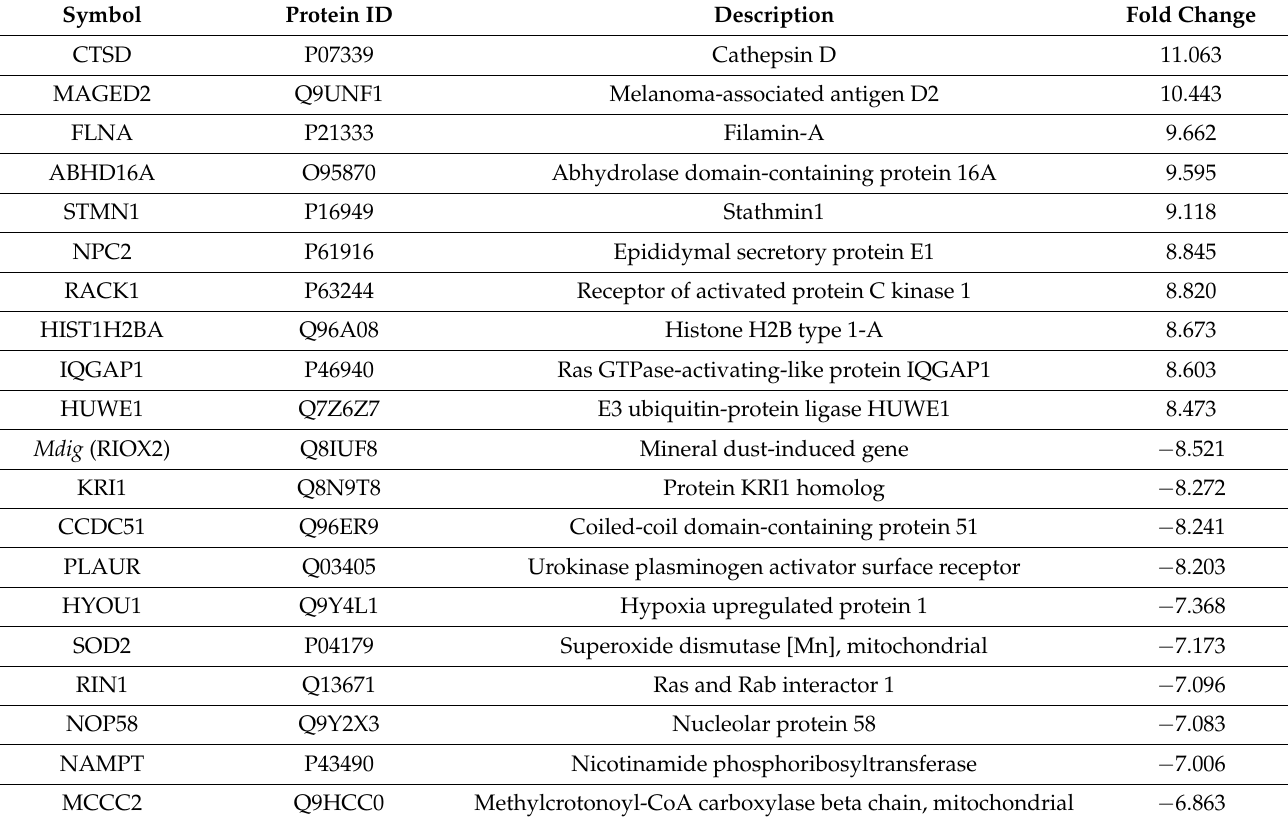
Table 1. Top 10 most differentially expressed proteins in mdig KO vs. WT MDA-MB-231 cells ( p < 0.005), as determined by the proteomics dataset obtained through mass